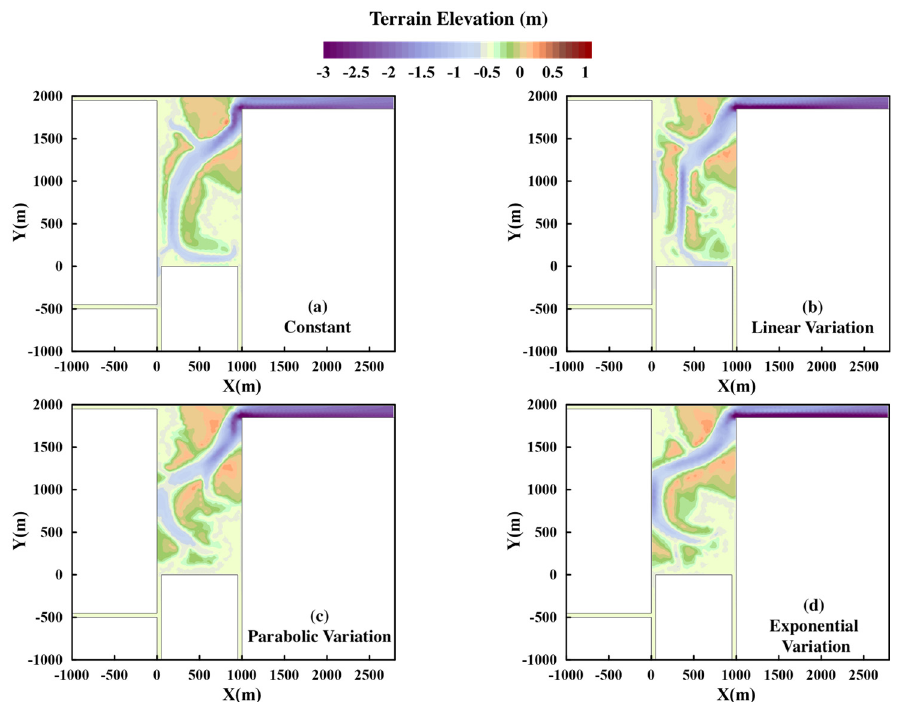
Figure 13. Terrain of the ideal model of Qilihai Lagoon system processes after 100 years under ( a ) constant, ( b ) linear, ( c ) parabolic and ( d ) exponential variation of sea level rise. Table 6. Erosion amount (EA), deposition amount (DA), and net erosion amount (NEA) per unit area for different sea level rise processes after 100 years.